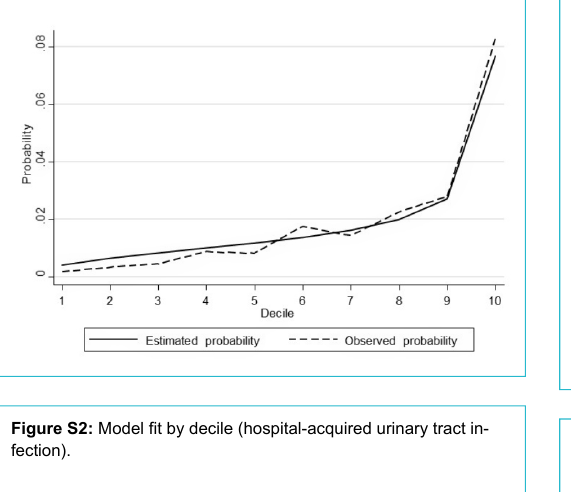
Figure S3: Model fit by decile (in-hospital mortality).